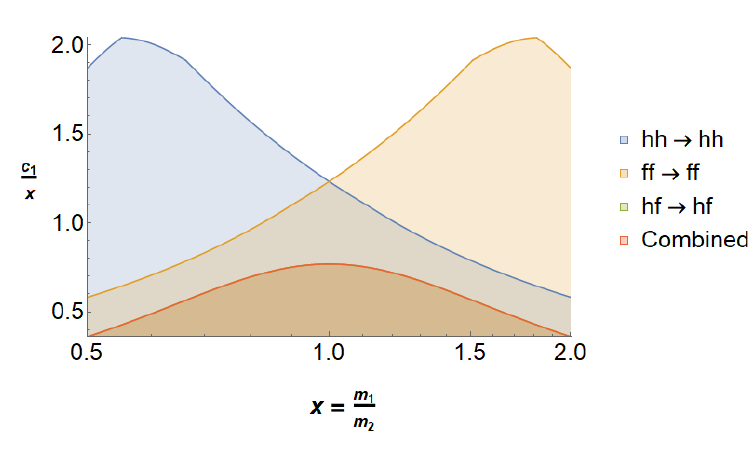
Figure 6 . The allowed values of the cubic coupling, c 1 , as a function of the mass ratio, x , for the case where all the couplings are equal and (cid:13) = 1. The allowed region is obtained from hh ! hh , ff ! ff and hf ! hf scattering. The maximal value for c 1 =x in the Z 2 case is at x = 1 and corresponds to 0.77. On the other hand, the maximum value of the cubic coupling c 1 occurs at x = 1 : 32 and is c 1max = 0 : 86. Positivity bounds from the mixing channels hf ! hf are more constraining than those from the single-(cid:12)eld channels hh ! hh and ff ! ff